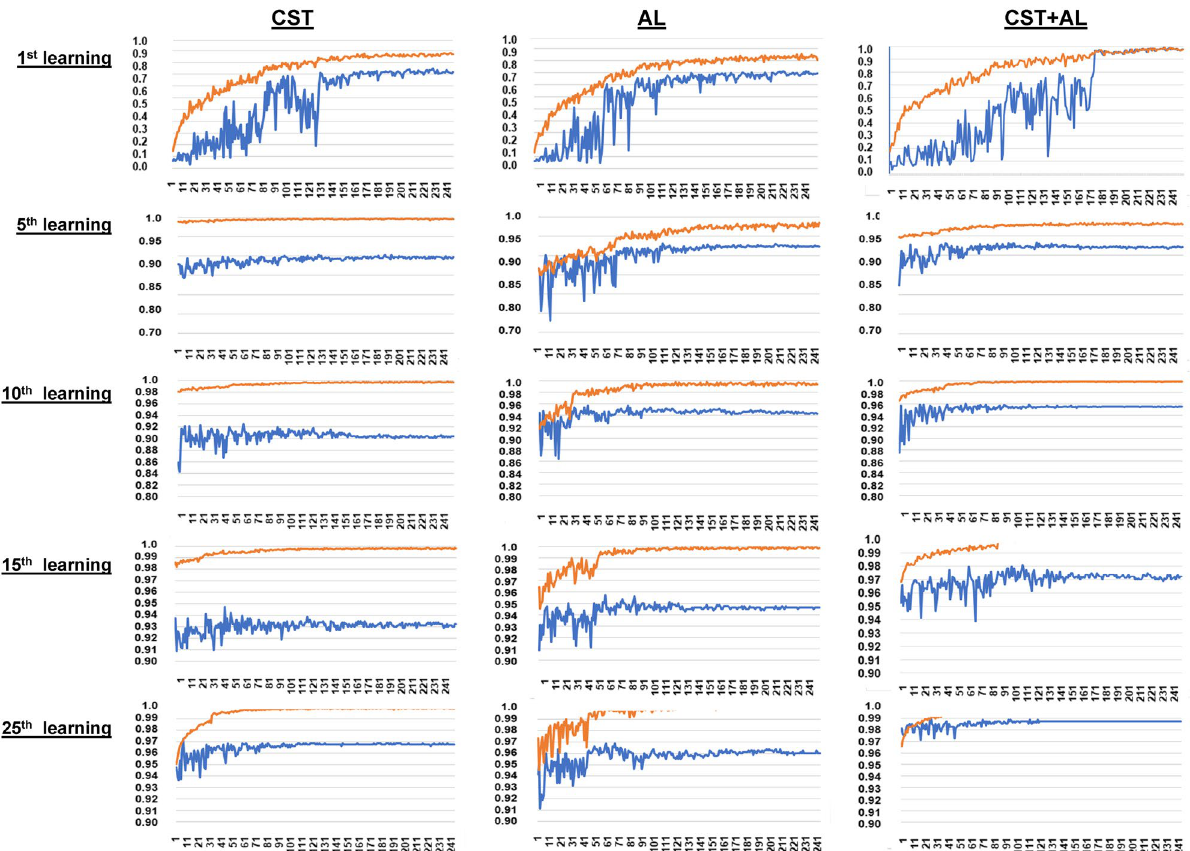
Figure 2. Learning curves of semi-supervised learning. The vertical axis of all learning curves indicates accuracy. The orange line indicates the accuracy for training data and the blue line indicates the accuracy for ld data. The scale of the vertical axis differs depending on the number of learnings, and the first learning was set from 0 to 1.0, 5th learning was set from 0.7 to 1.0, 10th learning was set from 0.8 to 1.0, and 15th and 25th learnings were set from 0.9 to 1.0. The horizontal axis of all learning curves indicates the count of epochs from 1 to